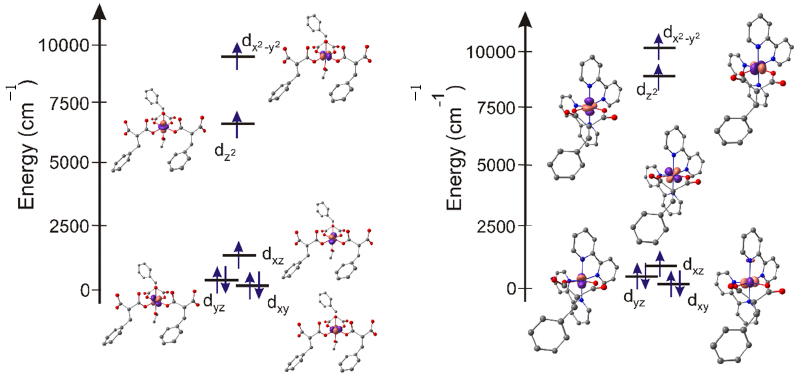
Figure 4. Co(II) ion d-AO splitting pattern in 1 ( left ) and 2 ( right ) according to AILFT analysis (at SA-CASSCF/NEVPT2 level of theory).